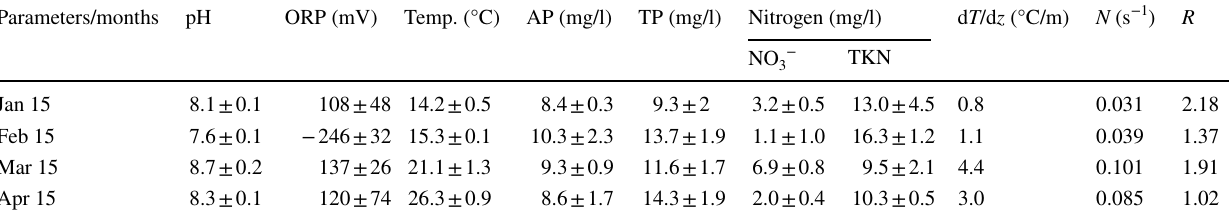
Table 1 Monthly variations of physico-chemical characteristics, thermal stratification (d T /d z ), buoyancy frequency ( N ), Richardson number ( R ) during the study Parameters/months